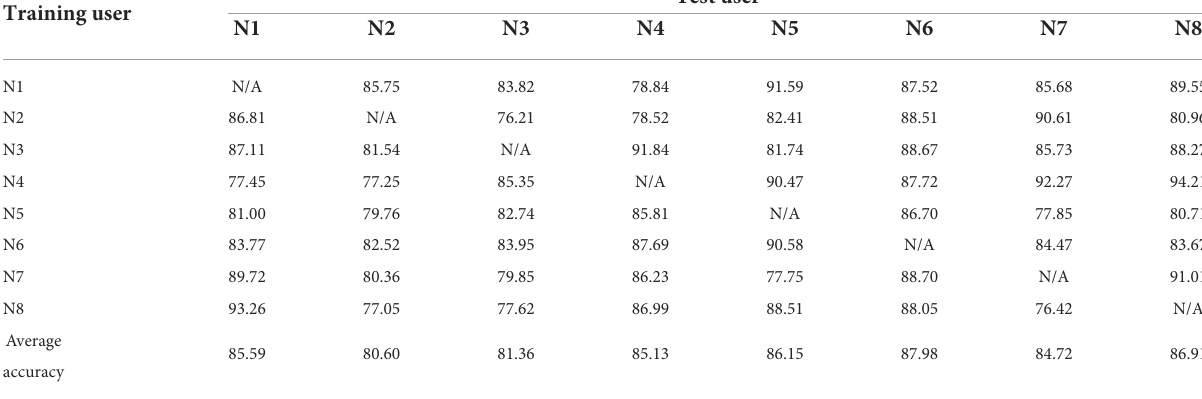
TABLE 7 Experimental results for user-independent CCA-with-ADR framework (the sEMG data of all test users were reduced randomly by two channels). Training